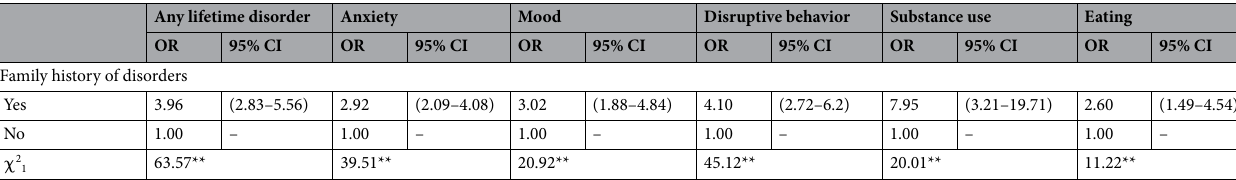
Table 3. Socio-demographic predictors of lifetime risk of DSM-IV/CIDI disorders in the SNMHS youth. Part II sample was used. *p < 0.05; **p < 0.001. Any disorder (n = 489); Anxiety (n = 331); Mood (n = 173); Disruptive